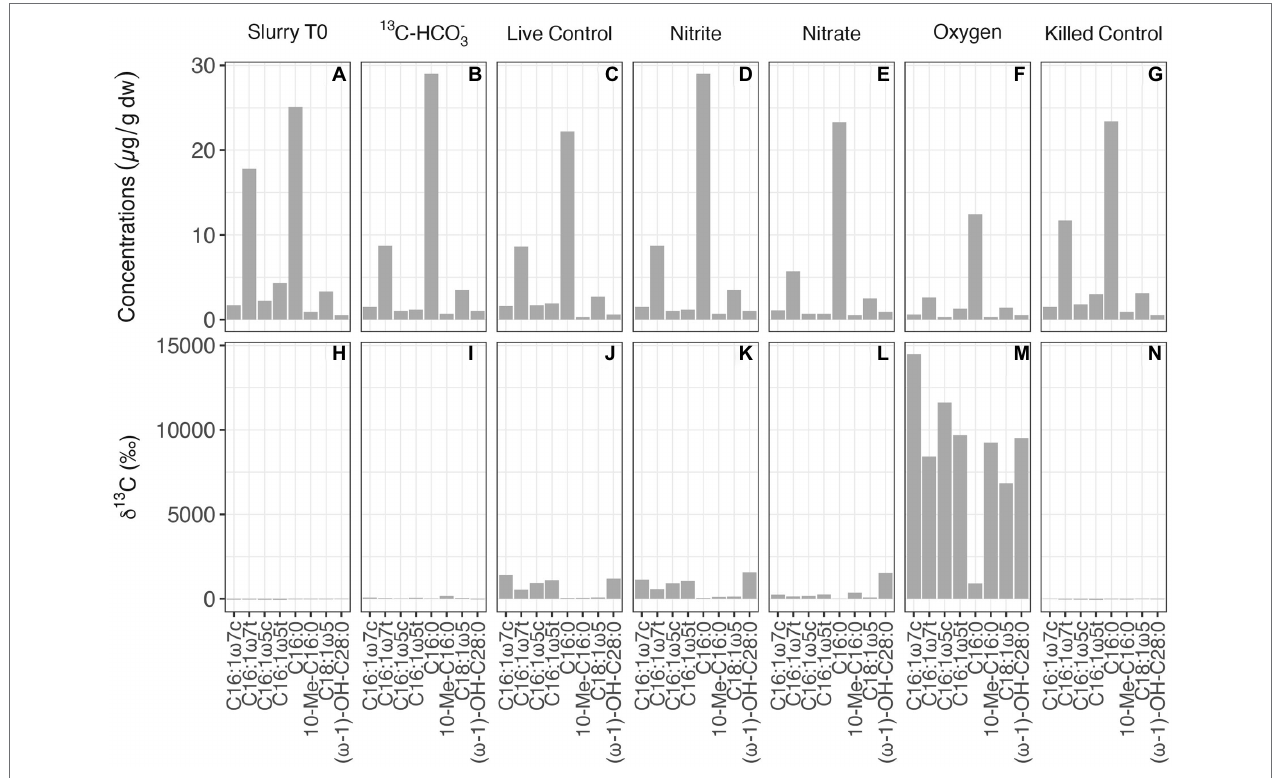
FIGURE 4 | Concentrations (A–G) and compound-specific δ 13 C values (H–N) of fatty acids diagnostic for putative methanotrophs in the initial slurry sample (Slurry T0), and in 13 CH 4 incubations with different treatments after 160